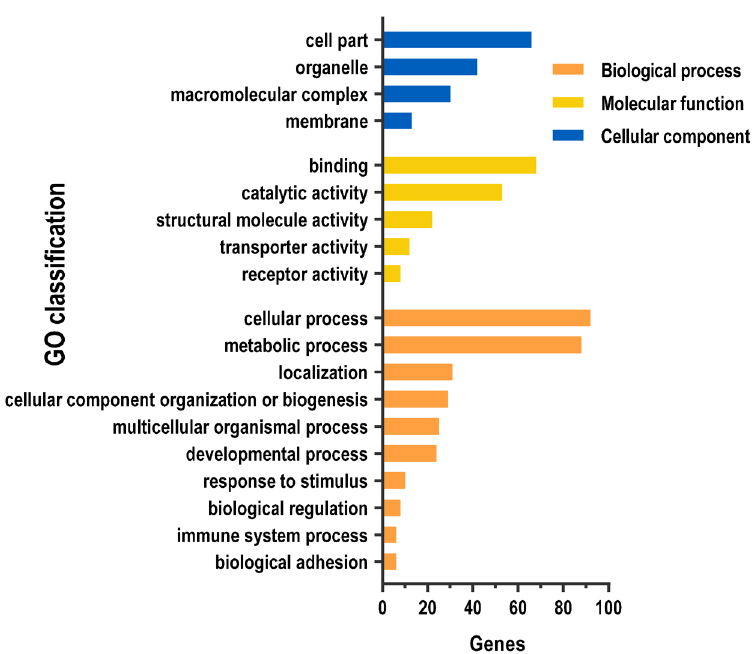
Figure 3. GO classification of miR-21-regulated proteins. GO distribution of miR-21- regulated proteins according to their biological process, molecular function and cellular component categories. Categorization was based on information provided by